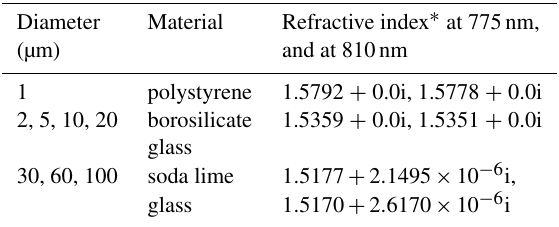
Table A1. Standard spherical particles used in the laboratory exper-